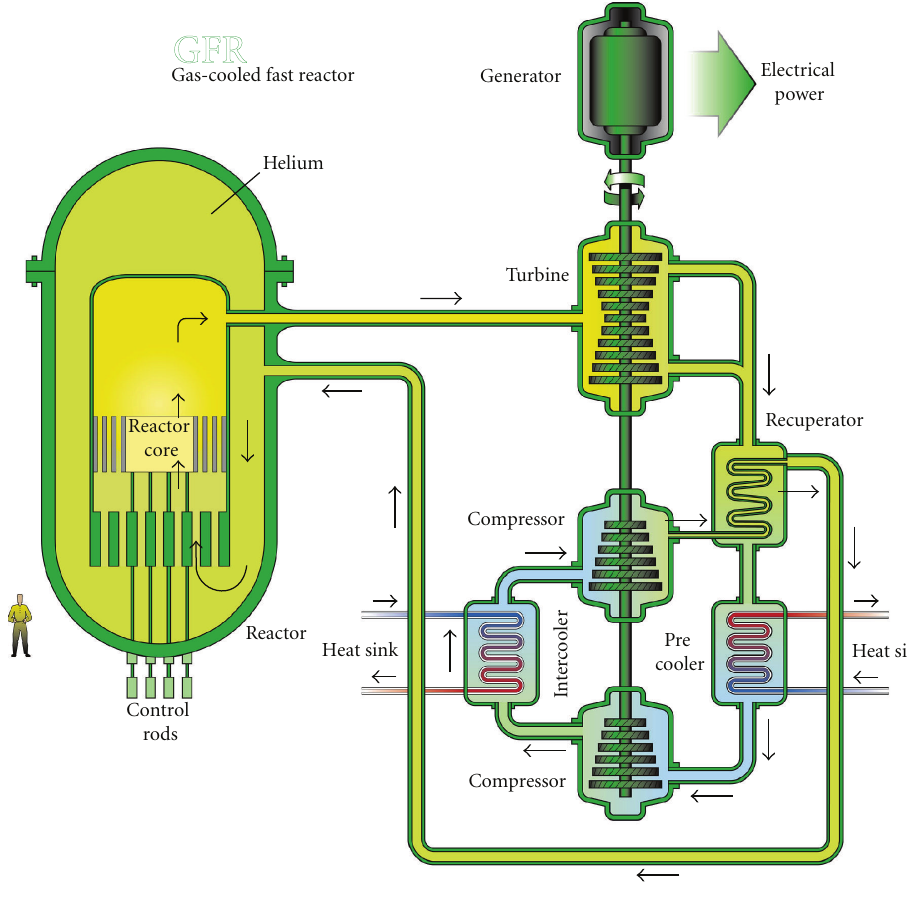
Figure 1: GCFR scheme